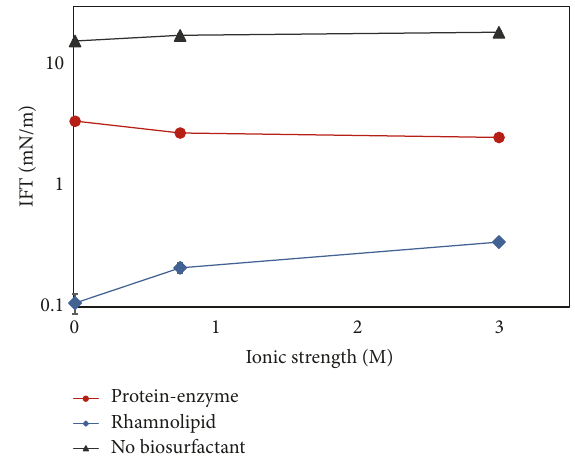
Figure 1: Crude oil-brine IFT as a function of the ionic strength. The symbols correspond to the three brines tested in this work: CSB (ionic strength 0.083 M); SW (ionic strength 0.75M); FMB (ionic strength 3M). The black line and triangles correspond to IFT measurements without any biosurfactant; the red line and symbols are the results of IFT measured in the system with 1 wt.% of greenzyme; the blue line shows the results obtained with 1 wt.% of rhamnolipid. The error bars in these experiments are based on the instrument accuracy and repeatability and do not exceed the size of the symbols in the figure.